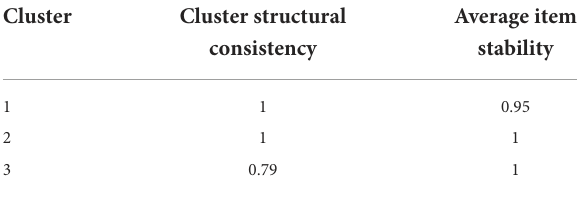
TABLE 4 Internal consistency of the